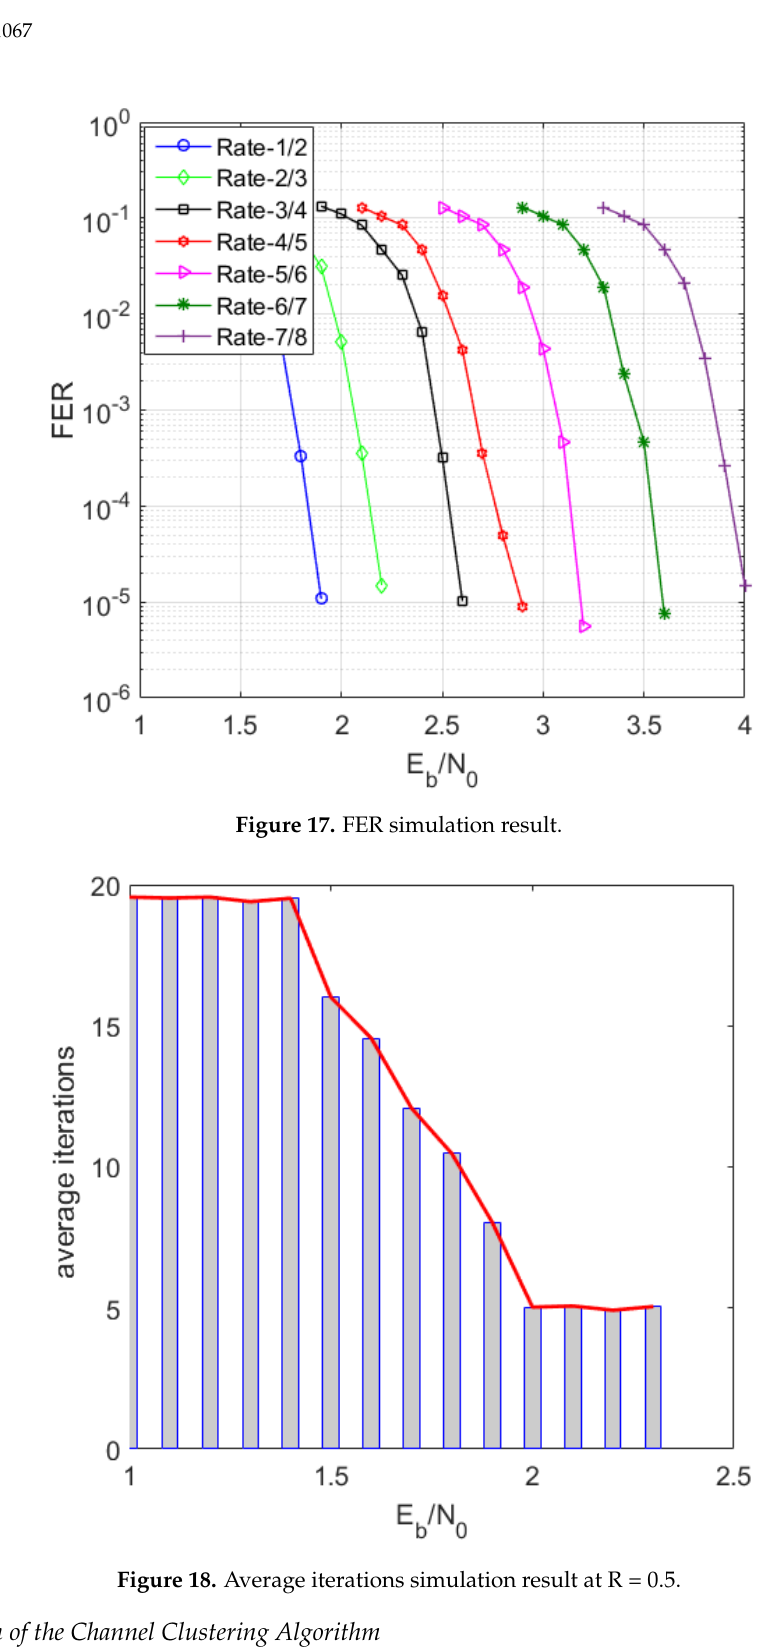
Figure 16. Designed 7/8 rate code performance.